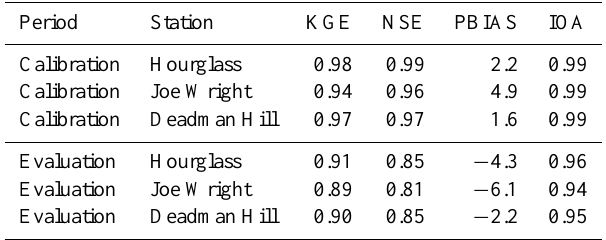
Table 5. Goodness of fit values for the calibration (top) and evalua- tion periods (bottom) for the site-specific calibrations at three SNO- TEL stations and for the model C2 at a daily time